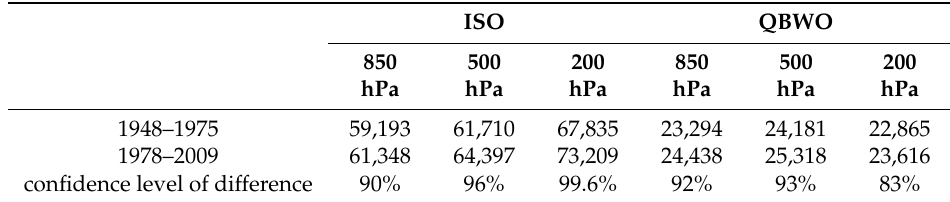
ISO QBWO 850 500 200 hPa hPa